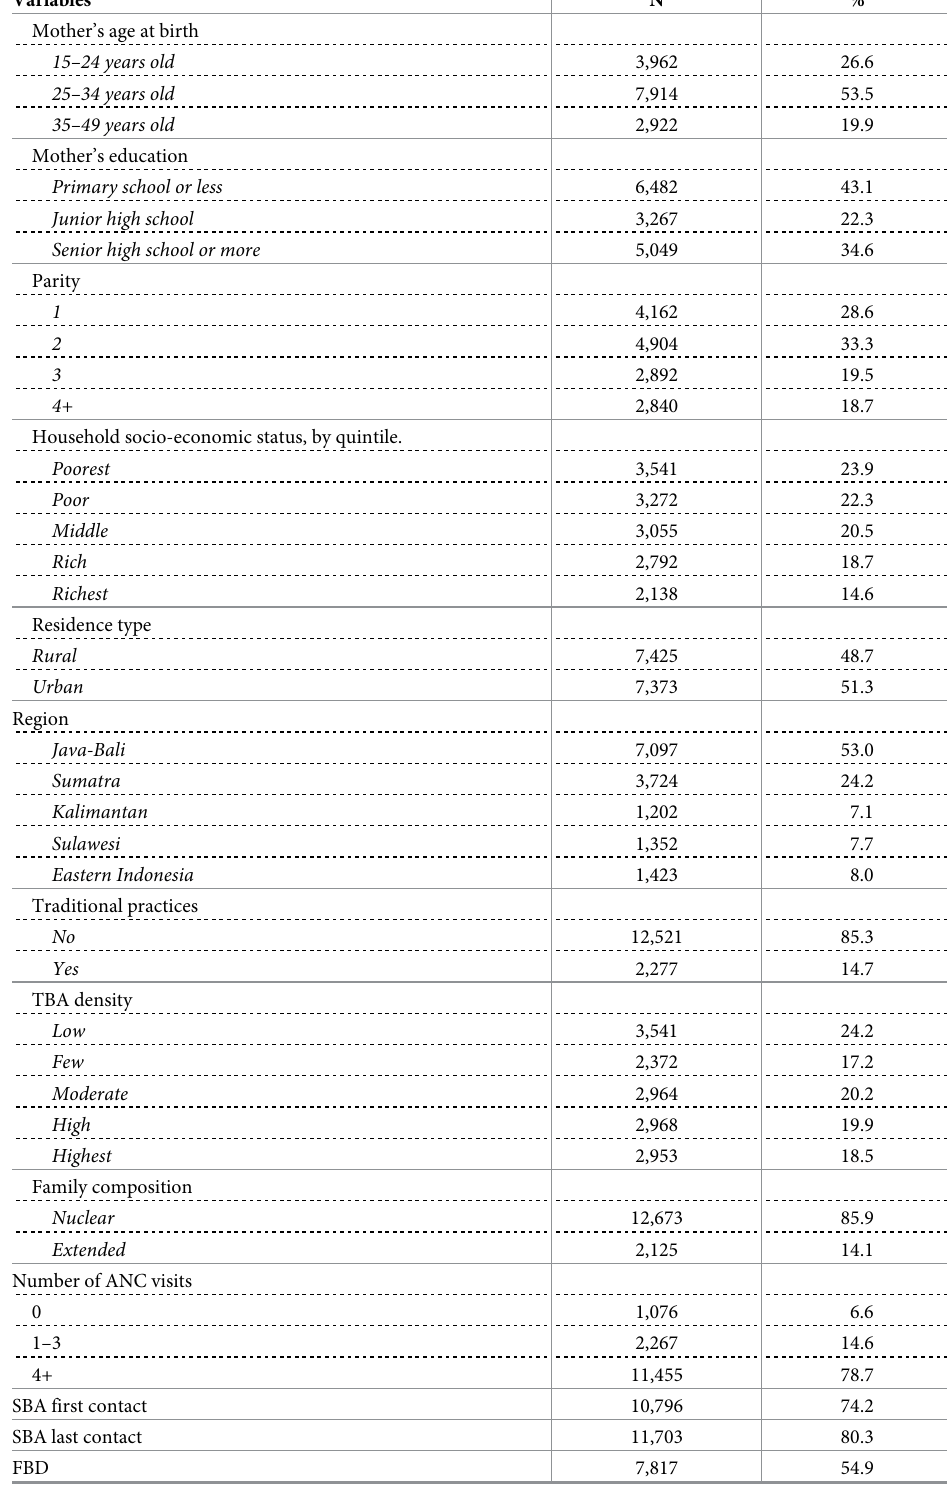
Table 1. Sample characteristics and utilization of maternal health